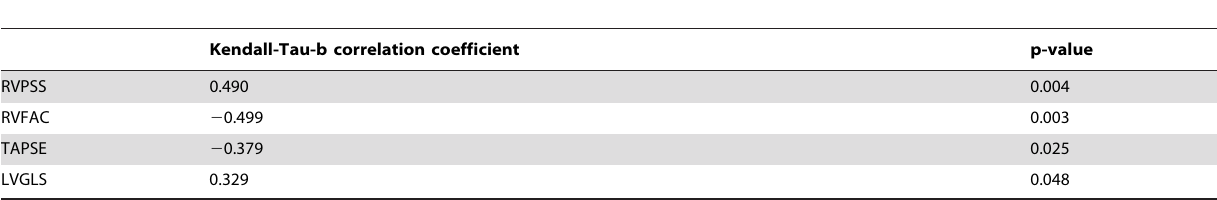
RV: right ventricular, TC: Takotsubo cardiomyopathy, RVPSS: right ventricular peak systolic strain, RVFAC: right ventricular fractional area change, TAPSE: tricuspid annular plane systolic excursion, LVGLS: left ventricular global strain.